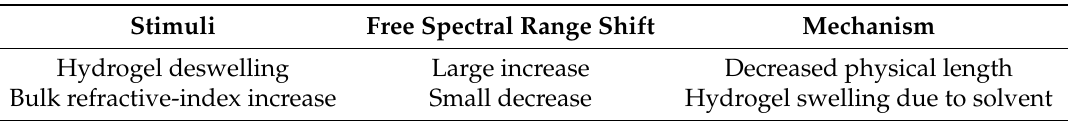
Table 1. Summary of results for interferometric sensor in the λ I